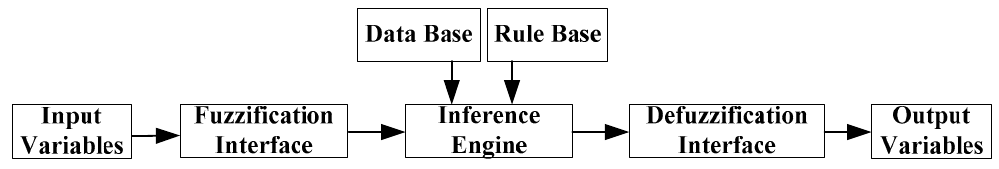
Figure 3. Basic architecture of a fuzzy control system.